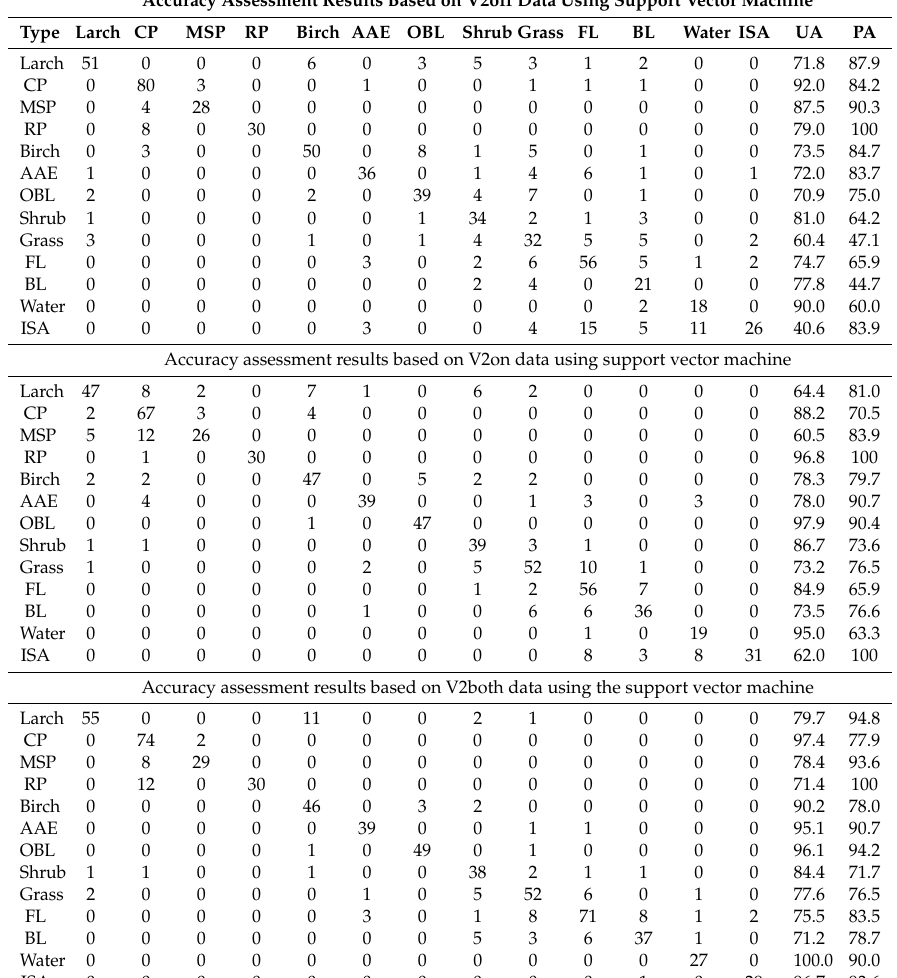
Table 6. The error matrix of classification results based on V2off, V2on, and V2both using the support vector